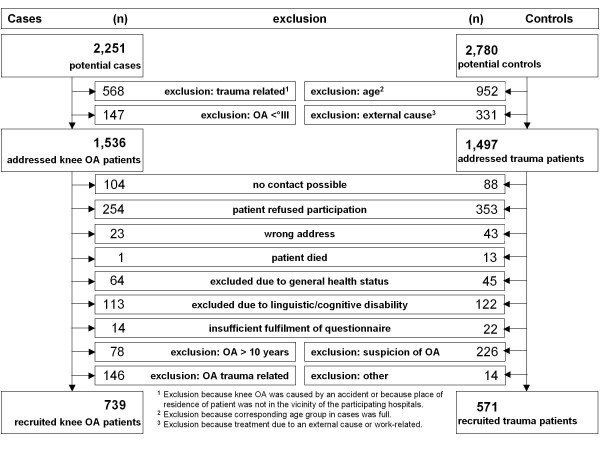
Recruitment of cases and controls. OA, osteoarthritis.